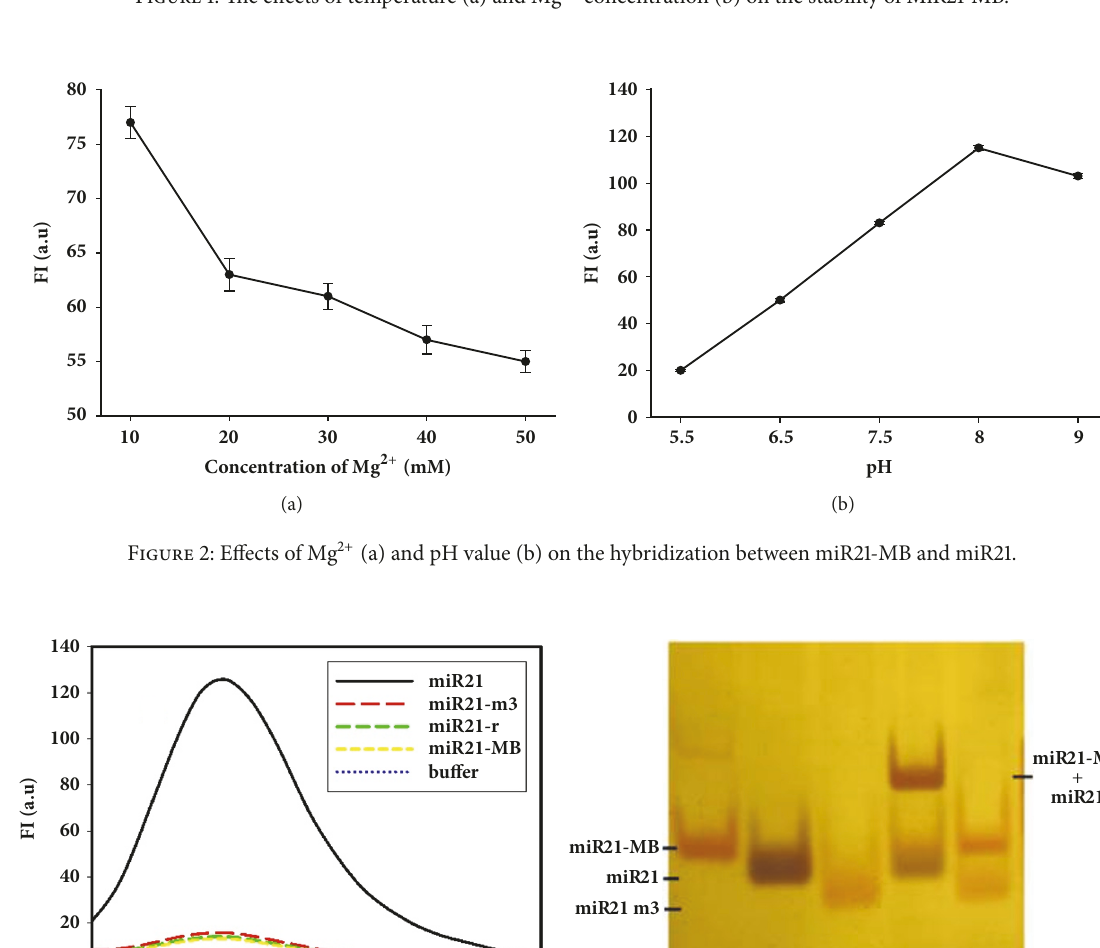
Figure 1: The effects of temperature (a) and Mg 2+ concentration (b) on the stability of MiR21-MB.